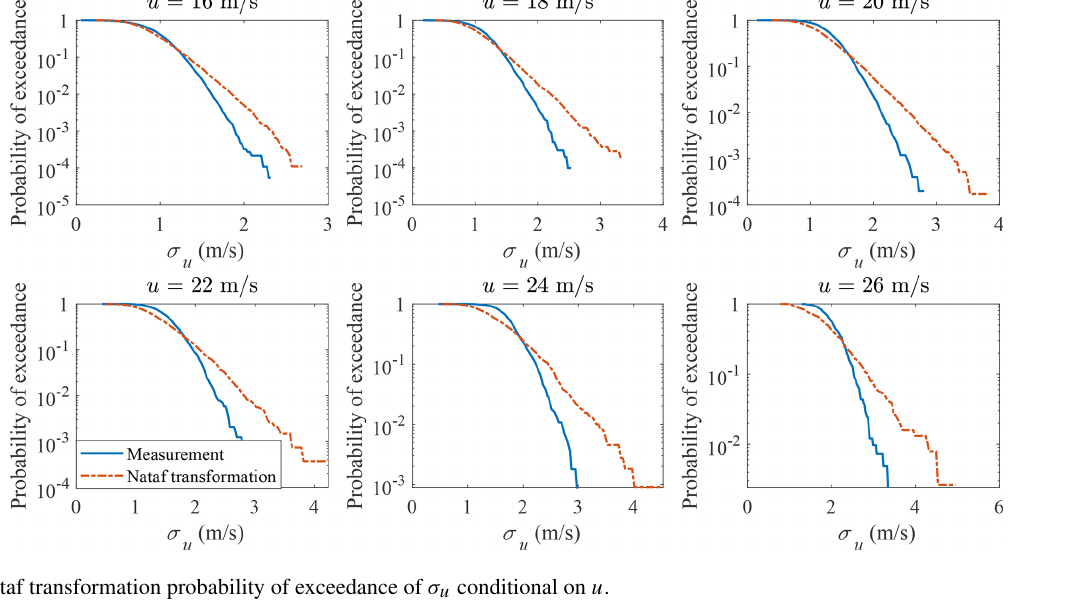
Figure 7. Nataf transformation probability of exceedance of σ u conditional on u .